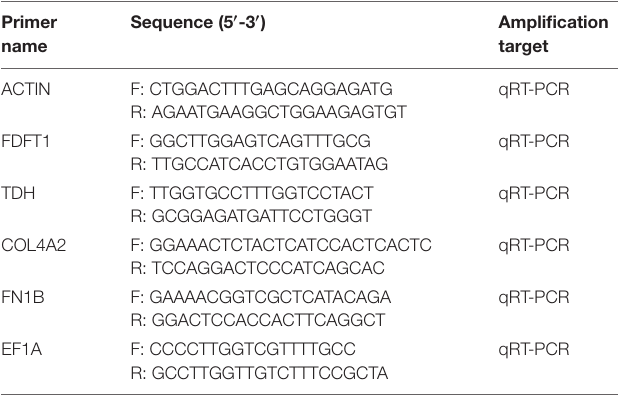
TABLE 1 | Primers used for actin, non-muscle (ACTIN), farnesyl-diphosphate farnesyltransferase 1 (FDFT1), L -threonine 3-dehydrogenase (TDH), collagen type IV alpha 2 (COL4A2), and fibronectin 1b (FN1B) gene expression analysis.